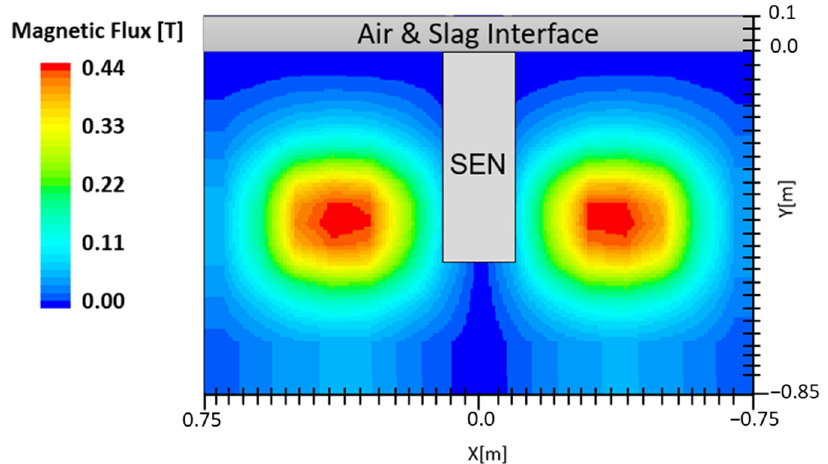
Figure 2. Applied magnetic field.